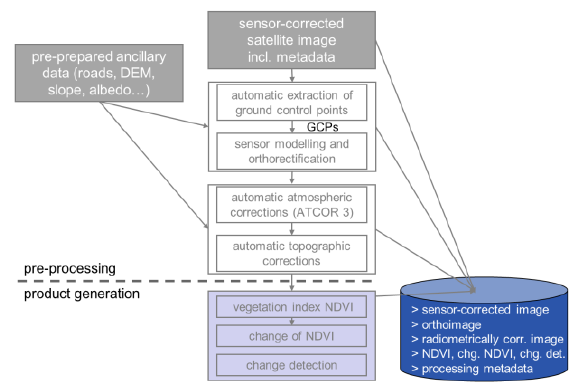
Figure 1. Workflow of the processing part of the STORM processing